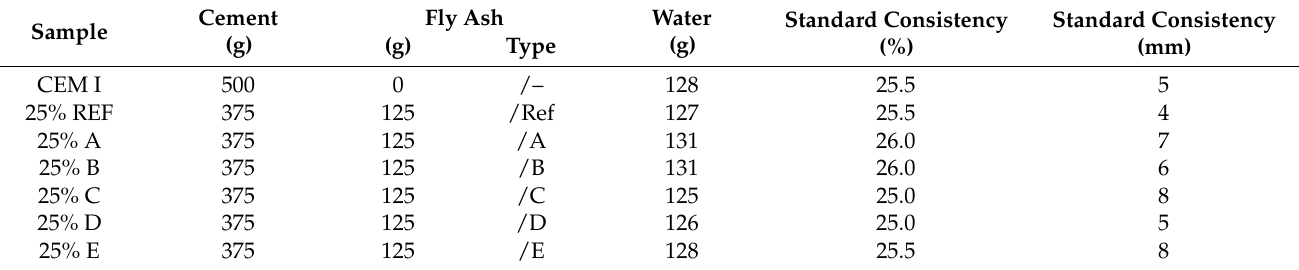
Table 4. Composition of tested